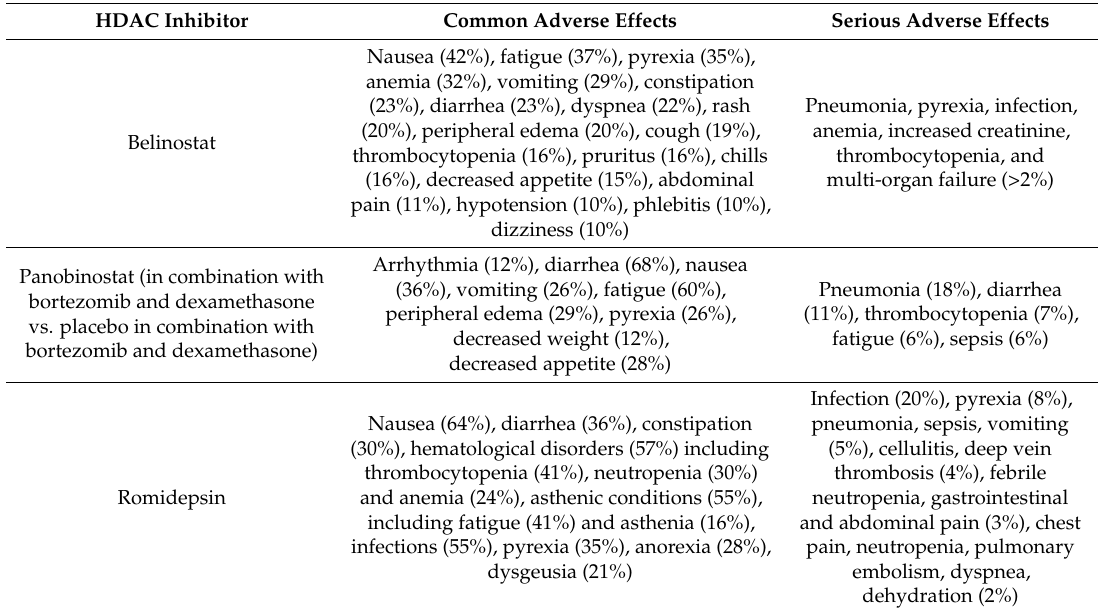
Table 3. Common adverse effects and serious adverse effects of U.S. FDA approved HDAC